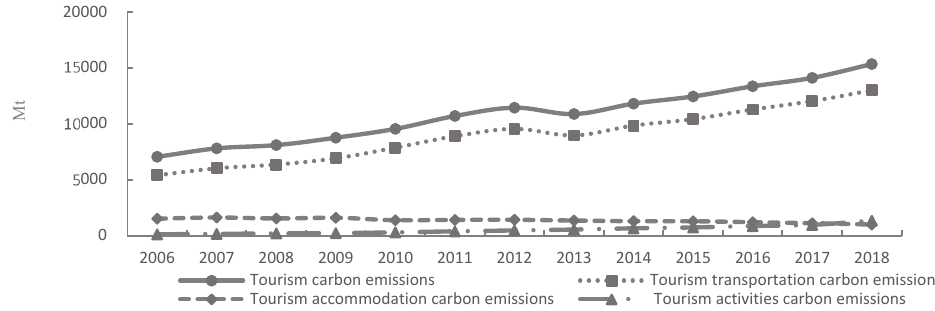
Figure 3. The estimated carbon emissions in tourism industry in China, 2006 to 2018. Note: Data is calculated and processed from this article.